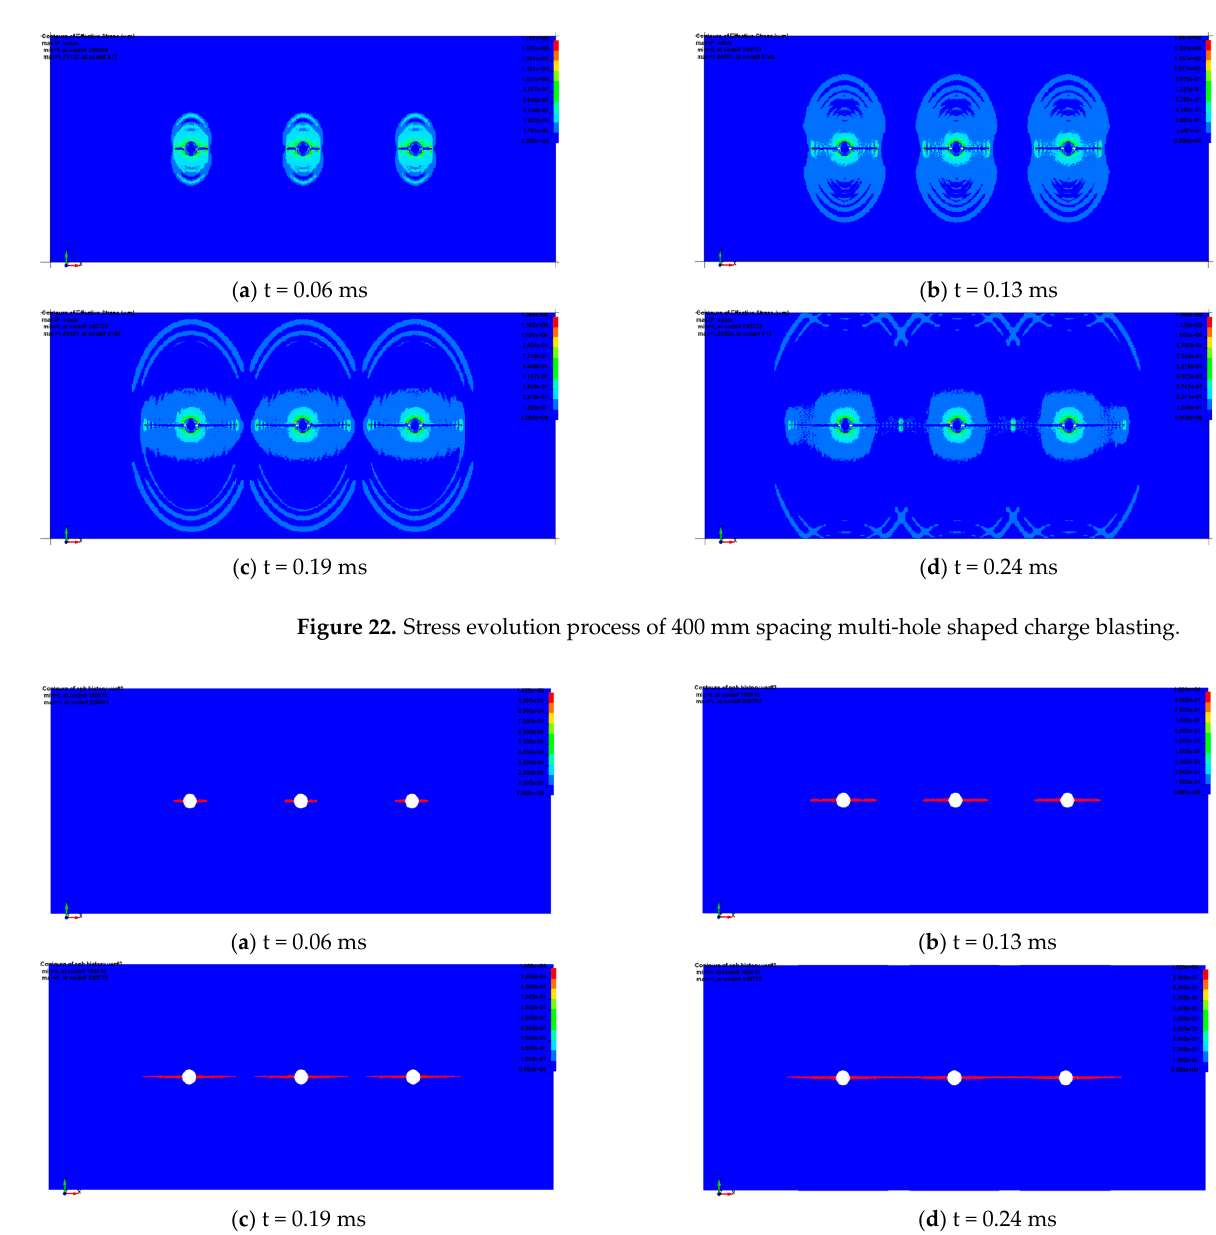
Figure 23. Development process of cracks caused by multi-hole blasting with 400 mm spacing.